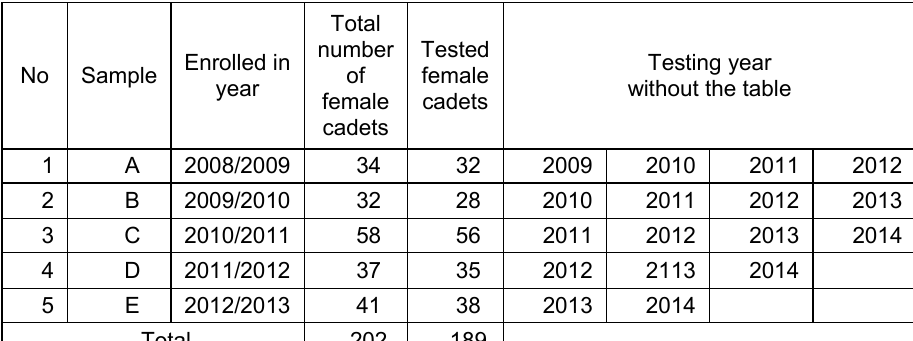
Table 1 – Test sample of female cadets used for table creation